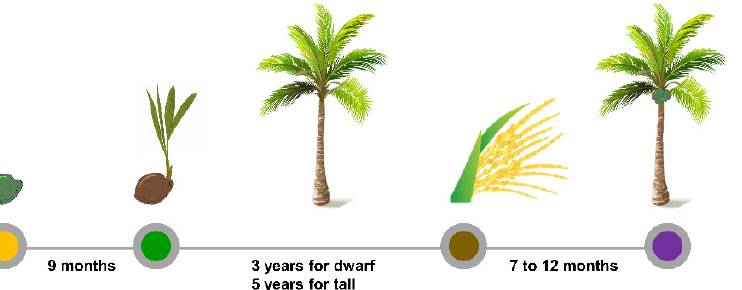
Figure 2. Life cycle of coconut palm. The duration of nut to sprout takes around 9 months, followed by the rapid formation of the haustorium and development of the root within several weeks. Then, at the juvenile stage (from sprouting stage to the first flower production), the growth in the tall variety is slower (5 years) and shorter in the dwarf (3 years). The flowers (male and female) are produced on a monthly basis at the spathe. In the second month of fertilization, the inner cavity will begin to differentiate. The fruit will take 7–12 months to reach its maximum size.